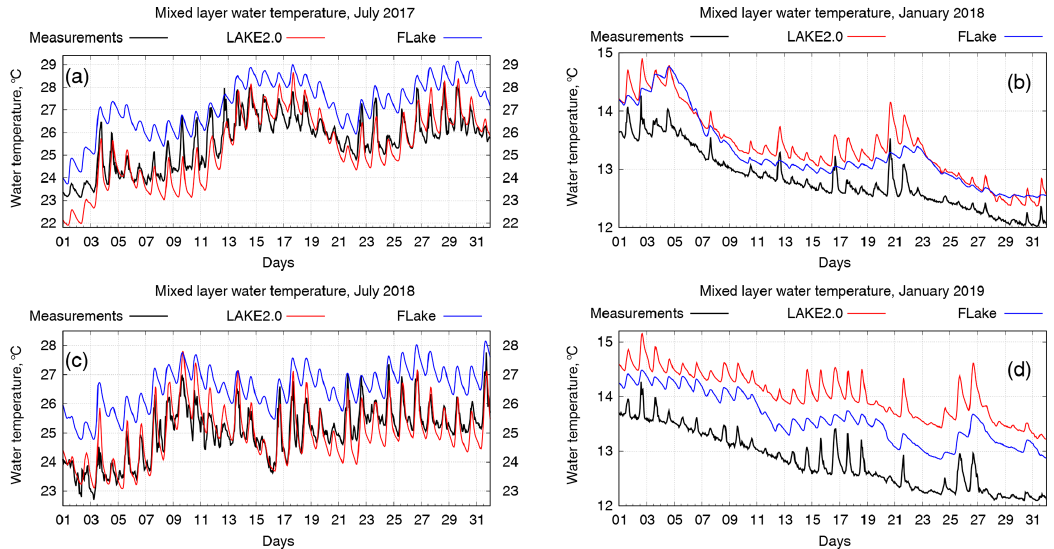
Figure 4. Time series of mixed layer water temperature for July 2017 and 2018 (a and c) and January 2018 and 2019 (b and d) .